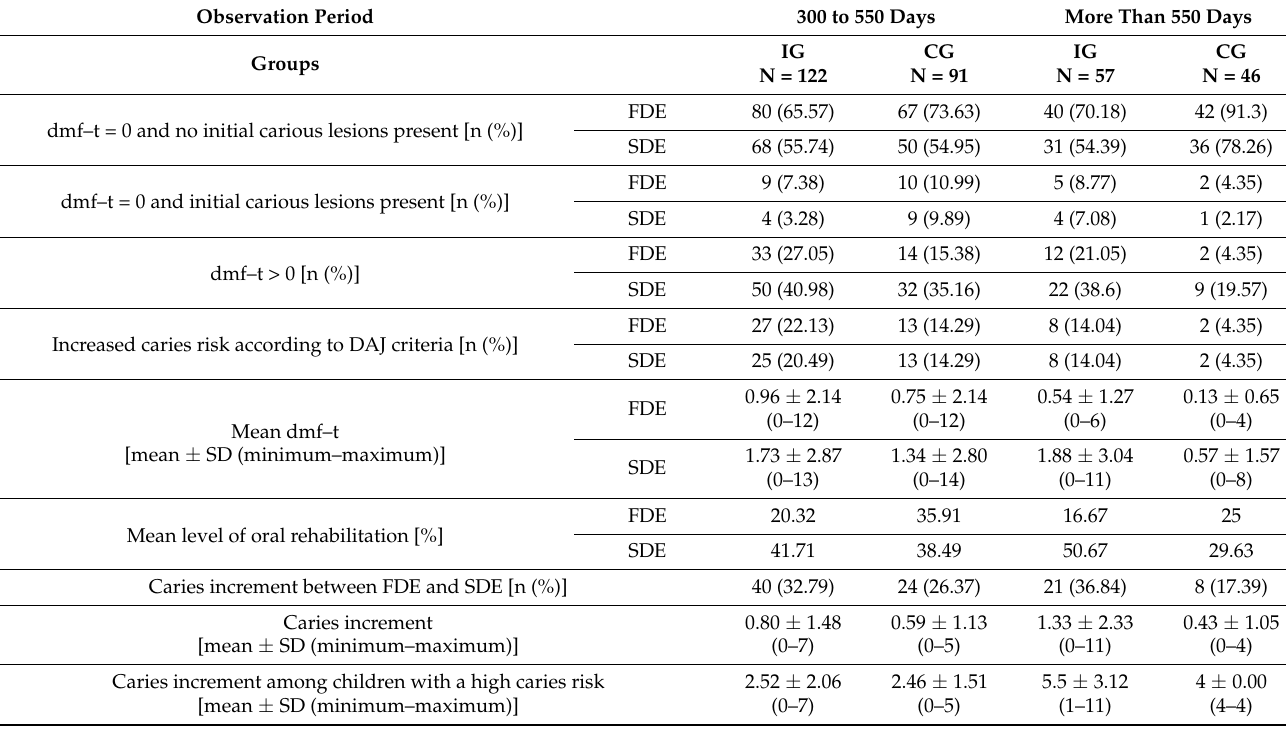
Abbreviations: CG, control group; DAJ, Deutsche Arbeitsgemeinschaft Jugendzahnpflege e. V. [39]; FDE, first dental examination; IG, intervention group; SDE, second dental examination; SD, standard